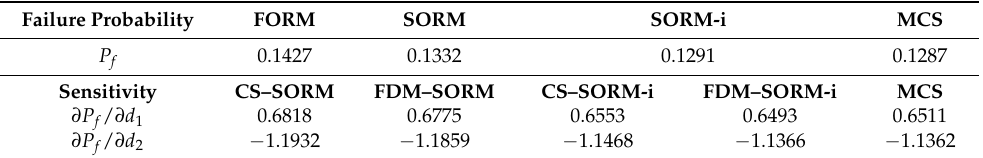
Table 2. Results of the assessment of the failure probability and sensitivity analysis by the FORM, CS–SORM, CS–SORM-i, and MCS at a point d =